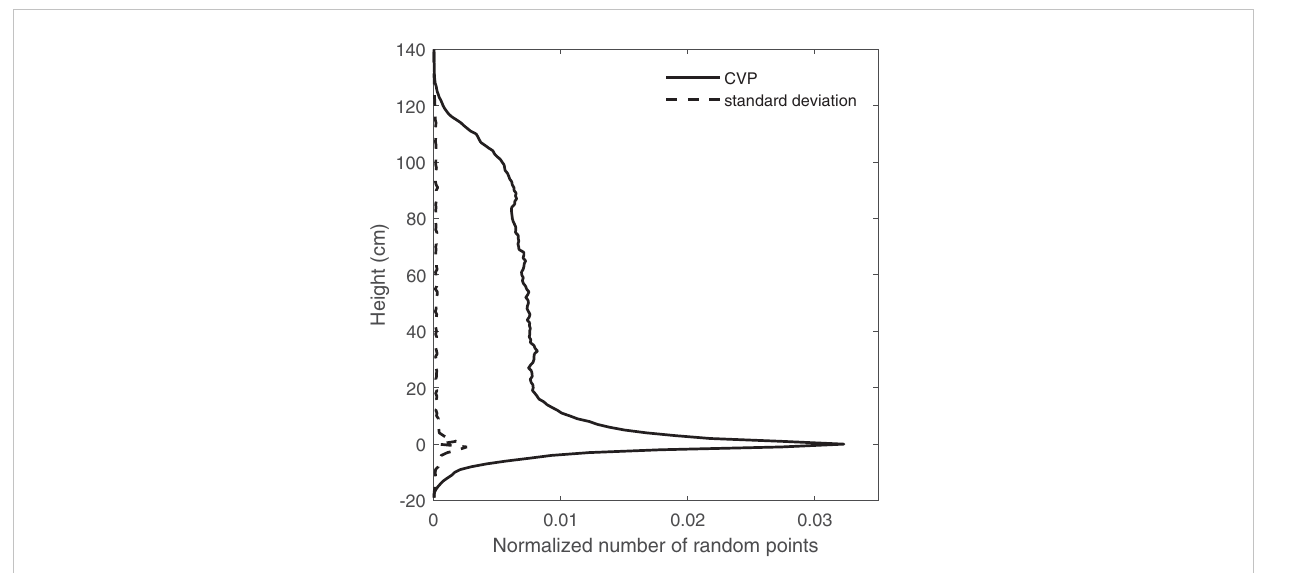
FIGURE 5 The average of 10 CVPs obtained from 800×240 random points and the standard deviation of these CPV graphs- in different canopy